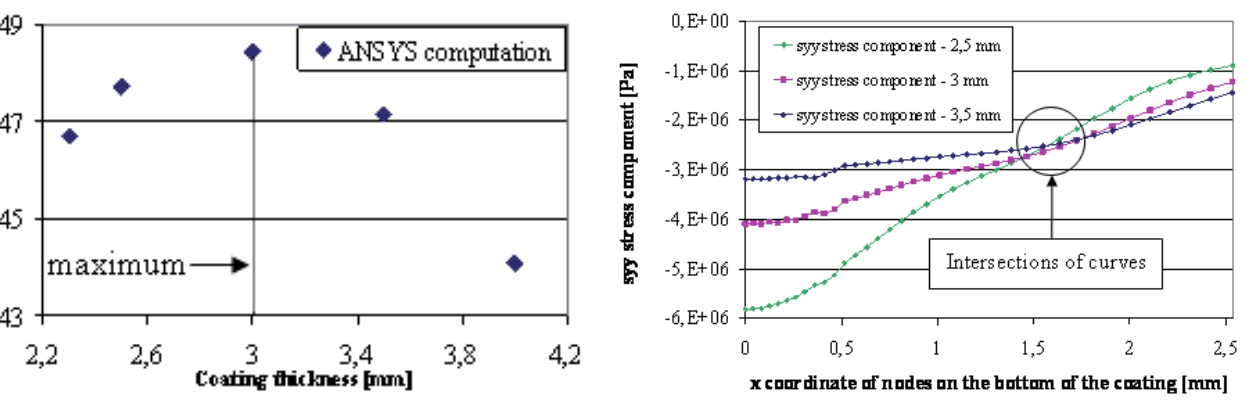
Fig. 14. σ yy stress component distributed on the central part of the bottom